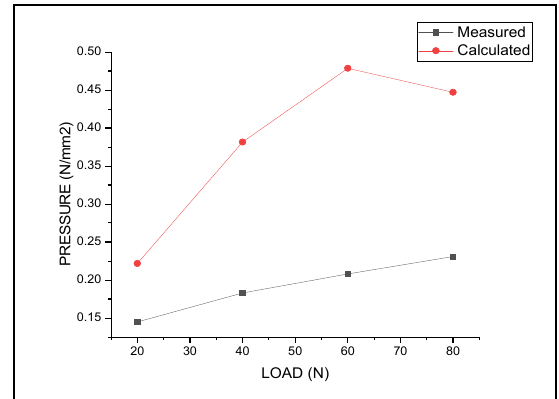
nominal method disports a linear trend from 200rpm to 800 rpm. The pressure values calculated through the proposed method have been elevated for each applied load. The interface pressure is inversely proportional to the area of contact. The increased pressure values depict the smaller contact area, i.e., the contacting interface is between the heightened asperities and the brake disc surface. Maximum value of interface pressure is 0.4 N/mm 2 , which can be acceptable for a dynamic system operating in high speed and relatively closed environ– ment. Decreasing trend of CoF at large velocities can be described as due to the high-velocity time required for asperity to contact also less. Thus, deformation reduces, which further reduces the real area of contact. Hence, CoF is lowered due to increasing velocity